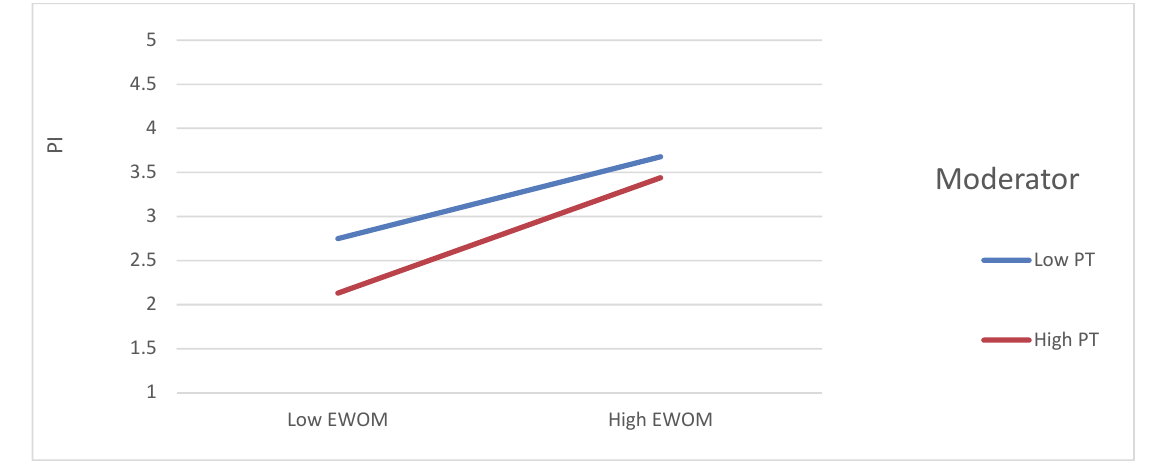
Fig. 3. Moderating impact of product type between EWOM and purchase intention